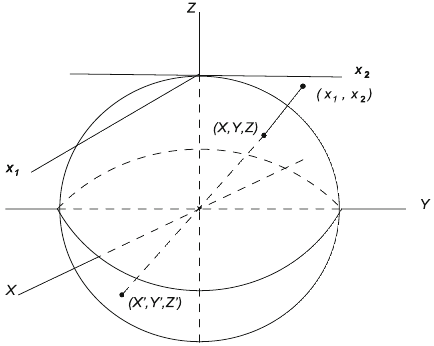
Fig. 3 Central projection of the upper hemisphere of S 2 (Poincaré sphere) onto the ( x 1 , x 2 ) plane